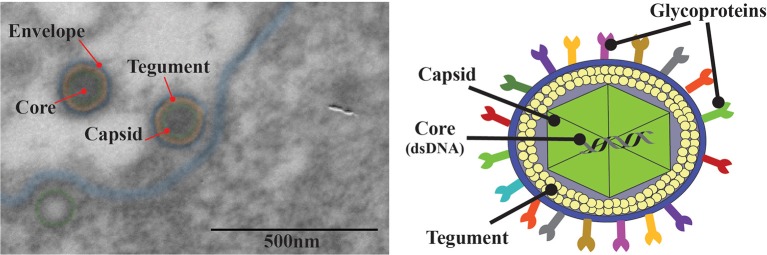
Structure of herpes simplex viruses. Left: Transmission electron microscopy (TEM) of HSV-2 infected Vero cells. The red arrow indicates the four main elements in the HSV-2 virion. An electron opaque core containing the viral DNA, an icosahedral capsid surrounding the capsid (green), the tegument that surrounds the capsid (orange) and an outer lipid bilayer envelope (blue). Right: Schematic illustration of HSV. The HSV virion is an enveloped, double-stranded DNA virus (~154 kpb) that encodes >80 genes; the viral genome is enclosed in an icosahedral capsid of ~125 nm surrounded by a complex mesh of viral proteins termed the tegument. HSV is enveloped with a lipid membrane that harbors numerous glycoproteins that protrude from the virion surface.